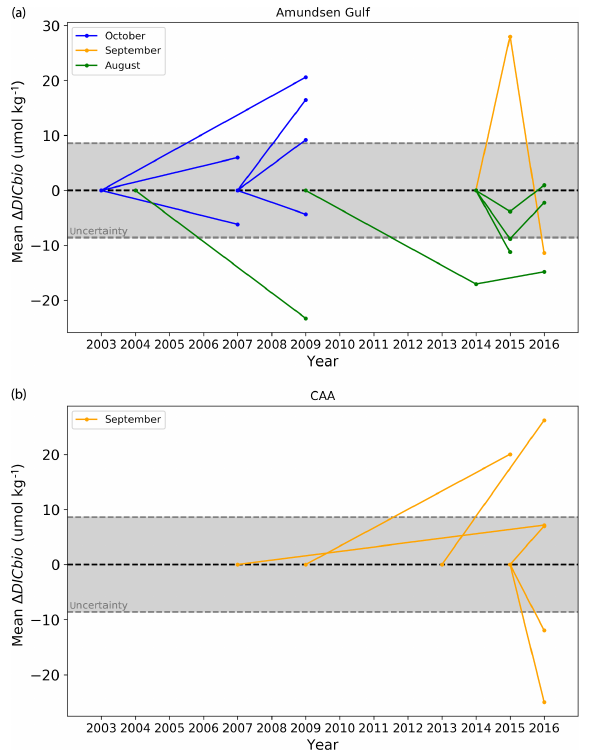
Figure 12. Mean (cid:49) DIC Bio (top 25m of the water column) at stations of the Amundsen Gulf (a) and Canadian Arctic Archipelago (b) . The central dashed line (0) is the reference state, in relation to which (cid:49) DIC Bio is expressed (i.e. the point at the right extremity of a line indicates the (cid:49) DIC Bio relative to the year at which this line intersects the central dashed line). The grey-shaded area represents the range of